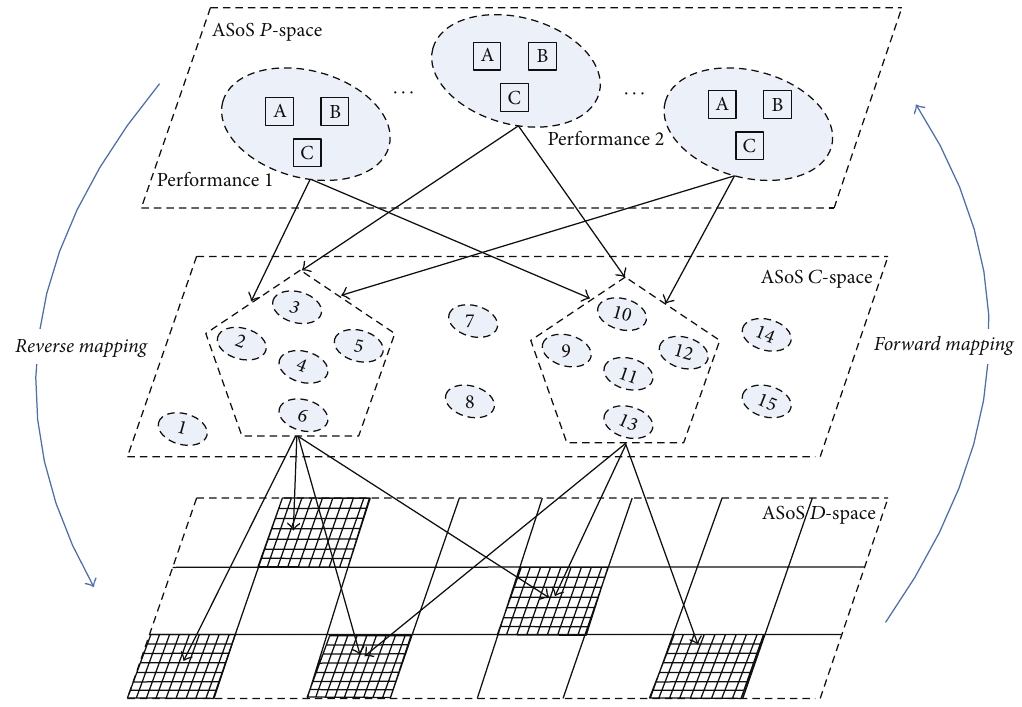
Figure 1: The general framework of the